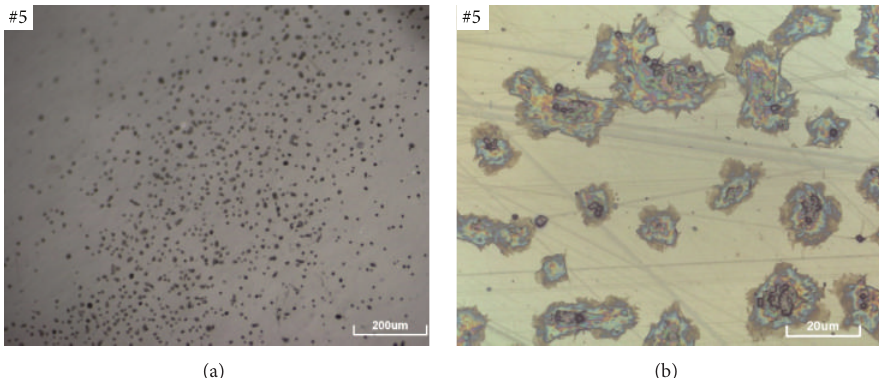
Figure 7: Optical image of platelets on surface of PET polymer treated in nitrogen plasma and coated with heparin (#5) after incubation with fresh blood at two different magnifications ((a) and